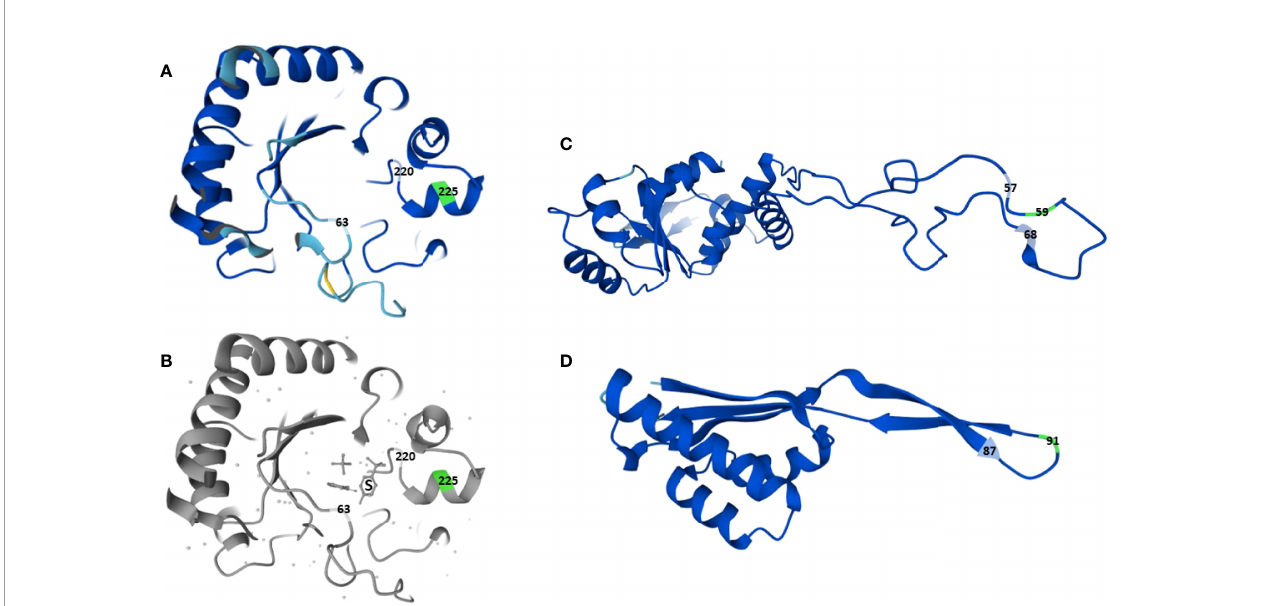
FIGURE 2 | Three-dimensional structure of dihydropteroate synthase (DHPS) and 50S ribosomal proteins L4 and L22 in H. in fl uenzae Rd KW20, with positions of newly acquired substitutions in strain Hi-197 highlighted (green). (A top left ) DHPS in Rd KW20 (P43776), with focus on the binding site for sulfonamides. (B bottom left ) , DHPS in E. coli K12 (P0AC13) with the sulfonamide molecule (S) sandwiched between amino acid positions 63 and 220. (C, D right ) , 50S ribosomal proteins L4 [P44345, (C top ) ] and L22 [P44360, (D bottom ) ] in Rd KW20, with focus on the highly conserved regions 57 KPWRQKGTGRAR 68 (L4) and 87 PRAKG 91 (L22) of the extended hairpin loops. Screenshots from UniProt (UniProt, 2021), licenced under CC BY